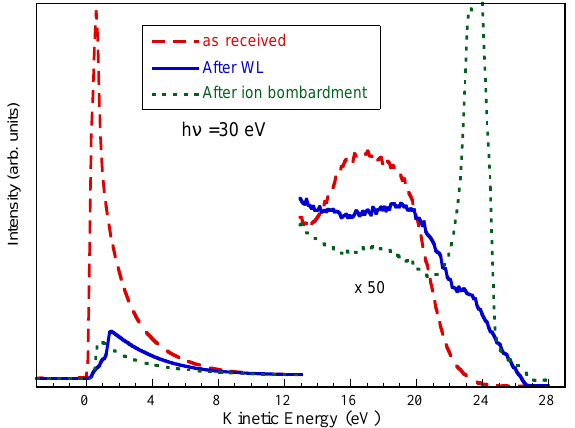
FIG. 5. (Color) The photoemission spectra, taken at 30 eV photon energy, of Cu as received, after WL exposure, and after Ar 1 sputtering